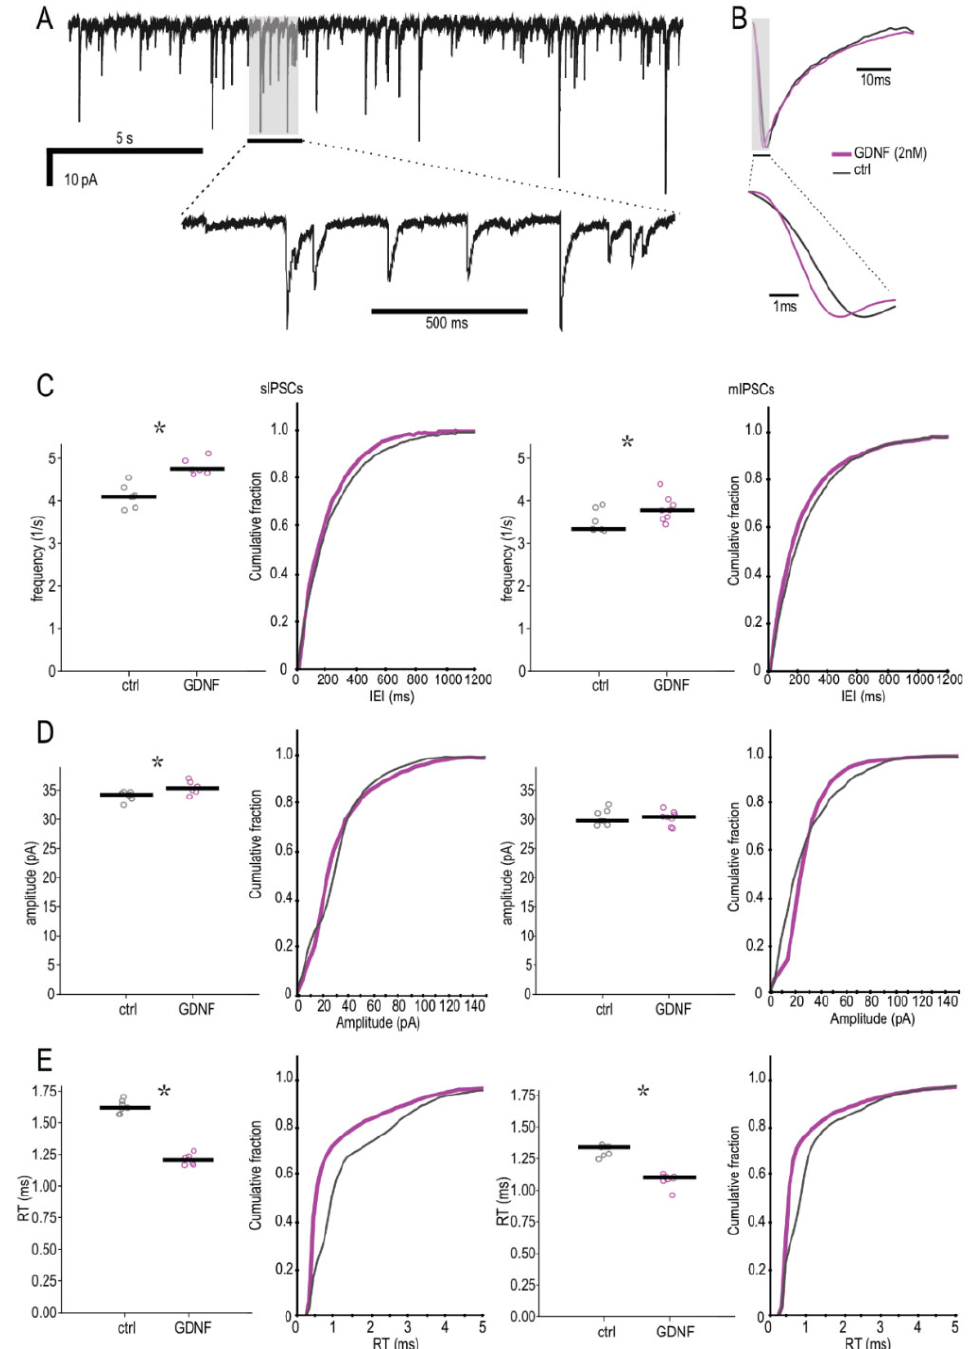
Figure 1. Quantification of GDNF effect on inhibitory postsynaptic currents. ( A ) Example trace of spontaneous IPSCs from a control slice. ( B ) Comparison of the averaged sIPSCs from a control and a GDNF ‐ incubated slice from the same animal, highlighting the difference in rise times (normalized amplitudes). ( C – E ) Inter ‐ event interval (K ‐ S sIPSCs p < 0.01 D = 0.238, mIPSCs p < 0.01 D = 0.075), amplitude (K ‐ S sIPSCs p < 0.01 D = 0.127, mIPSCs p < 0.01 D = 0.213) and rise ‐ time (K ‐ S sIPSCs p < 0.01 D = 0.350, mIPSCs p < 0.01 D = 0.309) cumulative distribution plots of spontaneous (left) miniature and IPSCs (right) from control and GDNF ‐ incubated slices (n = 352 events per cell). The line markers in the scatter plots depict the median of averages per cell. Mann–Whitney U ‐ test for the averages. * p < 0.05.